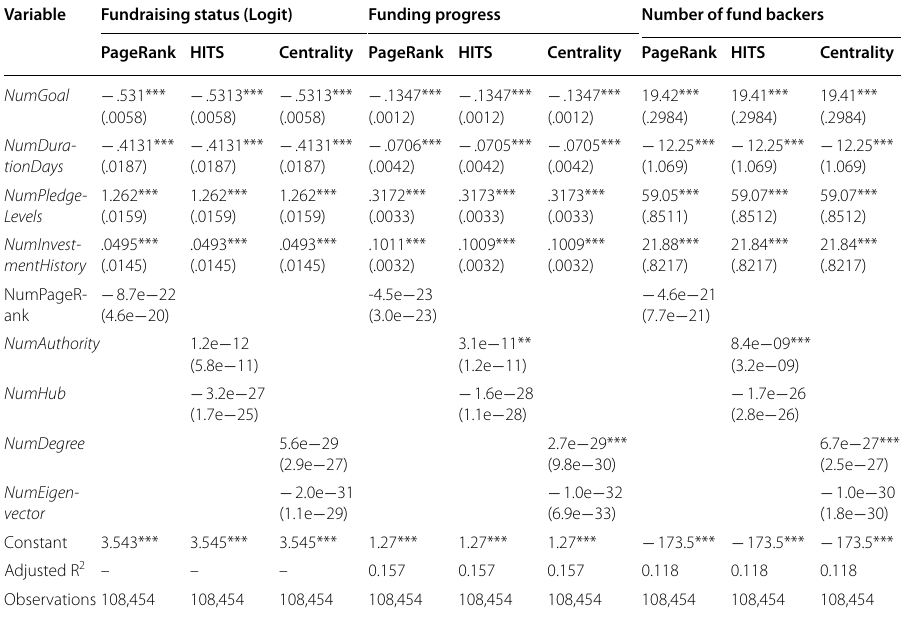
Table 7 Internal social connections on crowdfunding fundraising